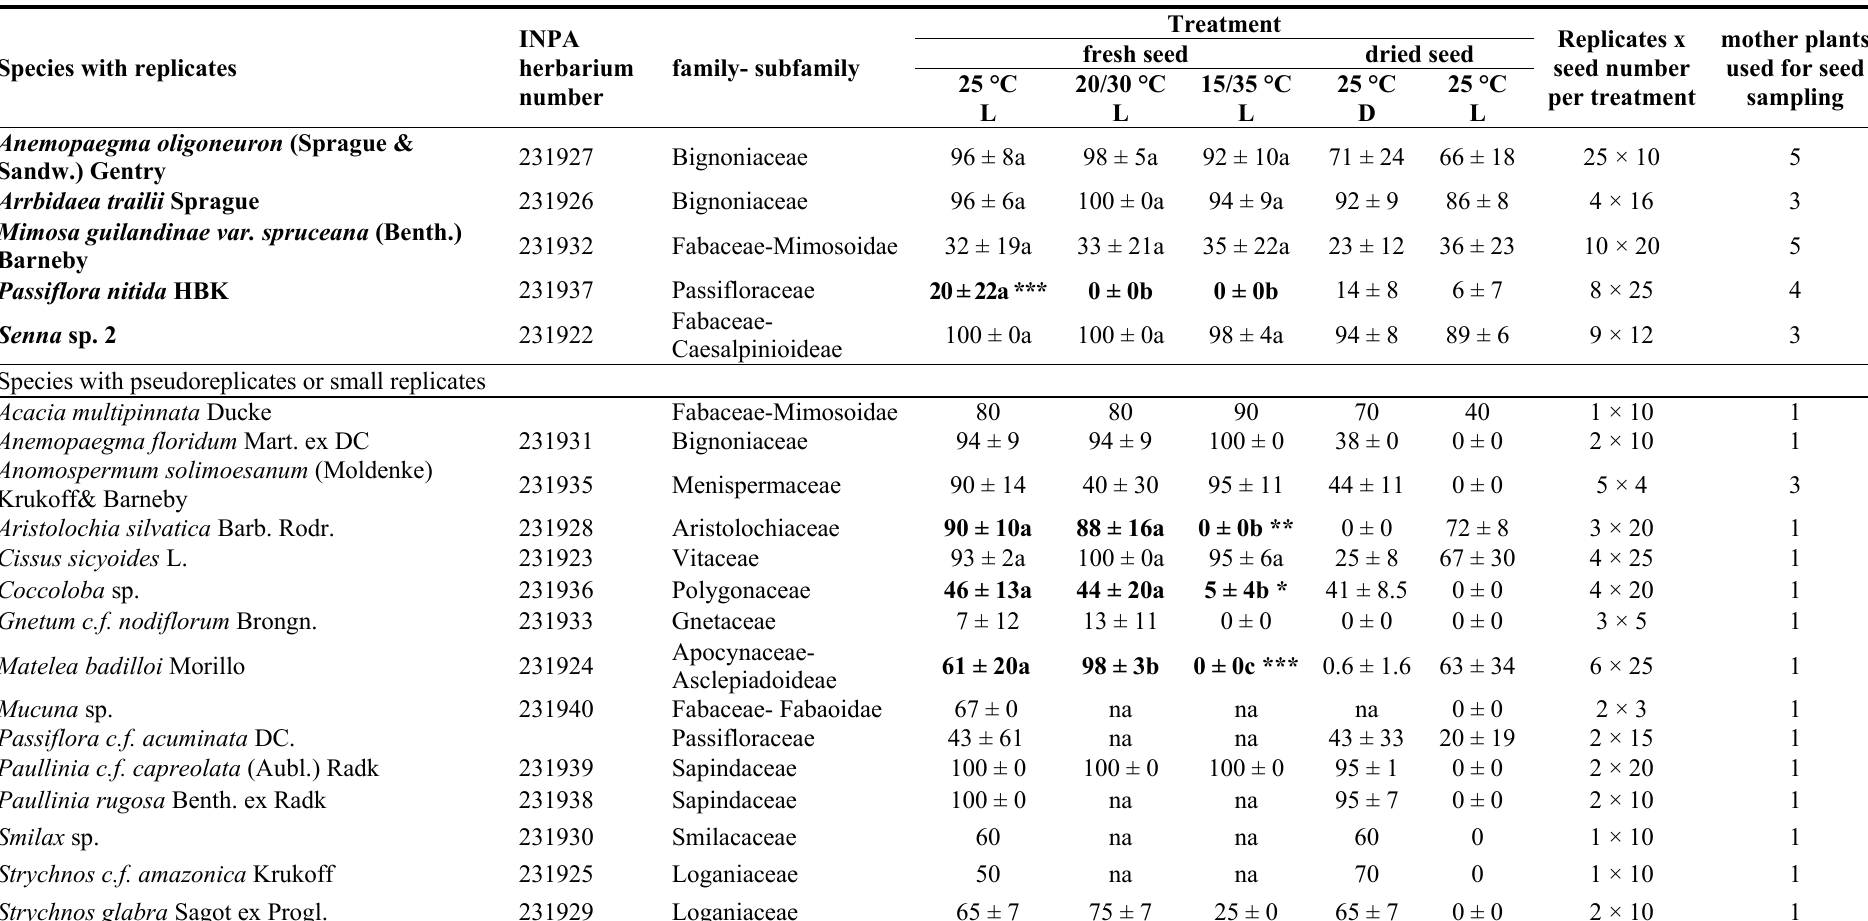
Table 1. List of 20 Central Amazonian liana species, the register number at the herbarium at Instituto Nacional de Pesquisas da Amazônia- INPA (Manaus, BR), their botanic family, final germination under various treatments and replicate numbers. Species with replicates